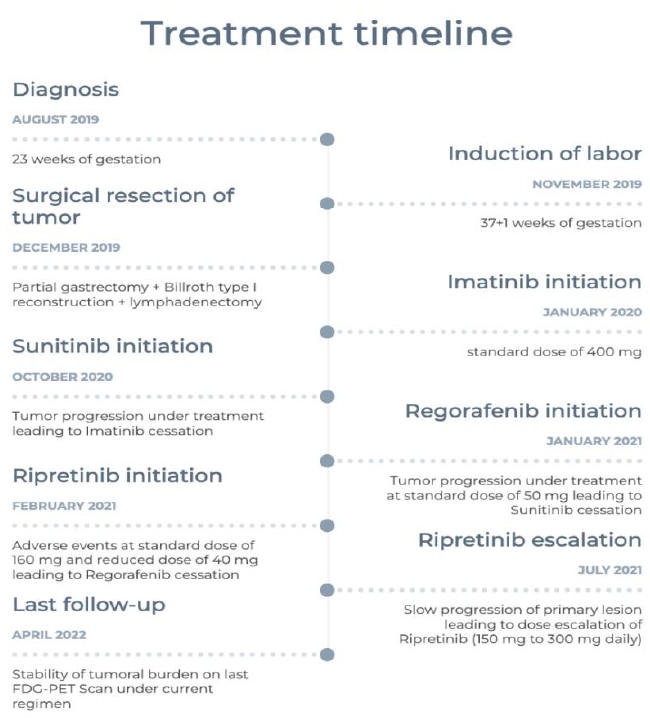
Figure 4. Nine-month follow-up FDG-TEP scan after introduction of imatinib, showing disease progression with new liver metastasis.